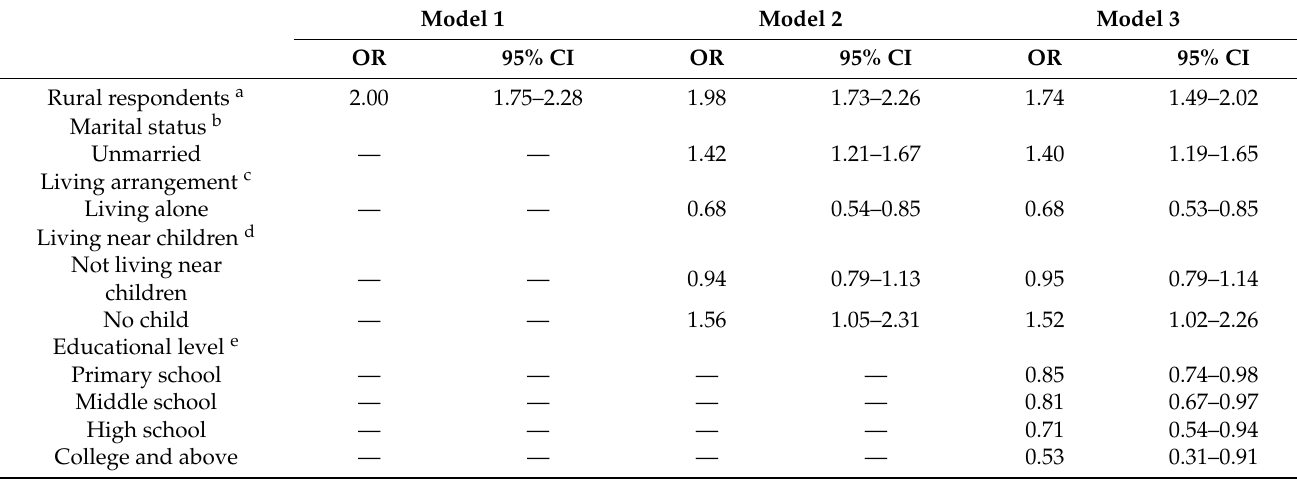
Table 6. Multiple logistic regression analyses on rural and urban respondents’ poor Self-Rated Health (SRH), adjusted for age and sex, CHARLS 2015 ( n =